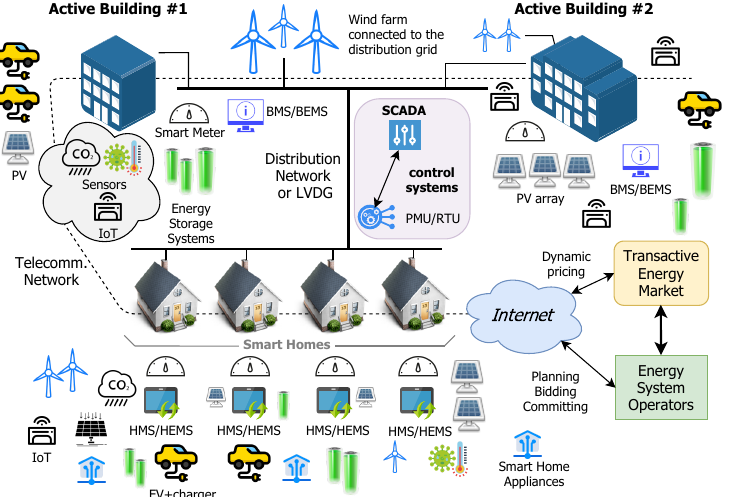
Figure 2. Overview of a tentative architecture and most likely devices that managers will deploy for enacting the active building business proposition.